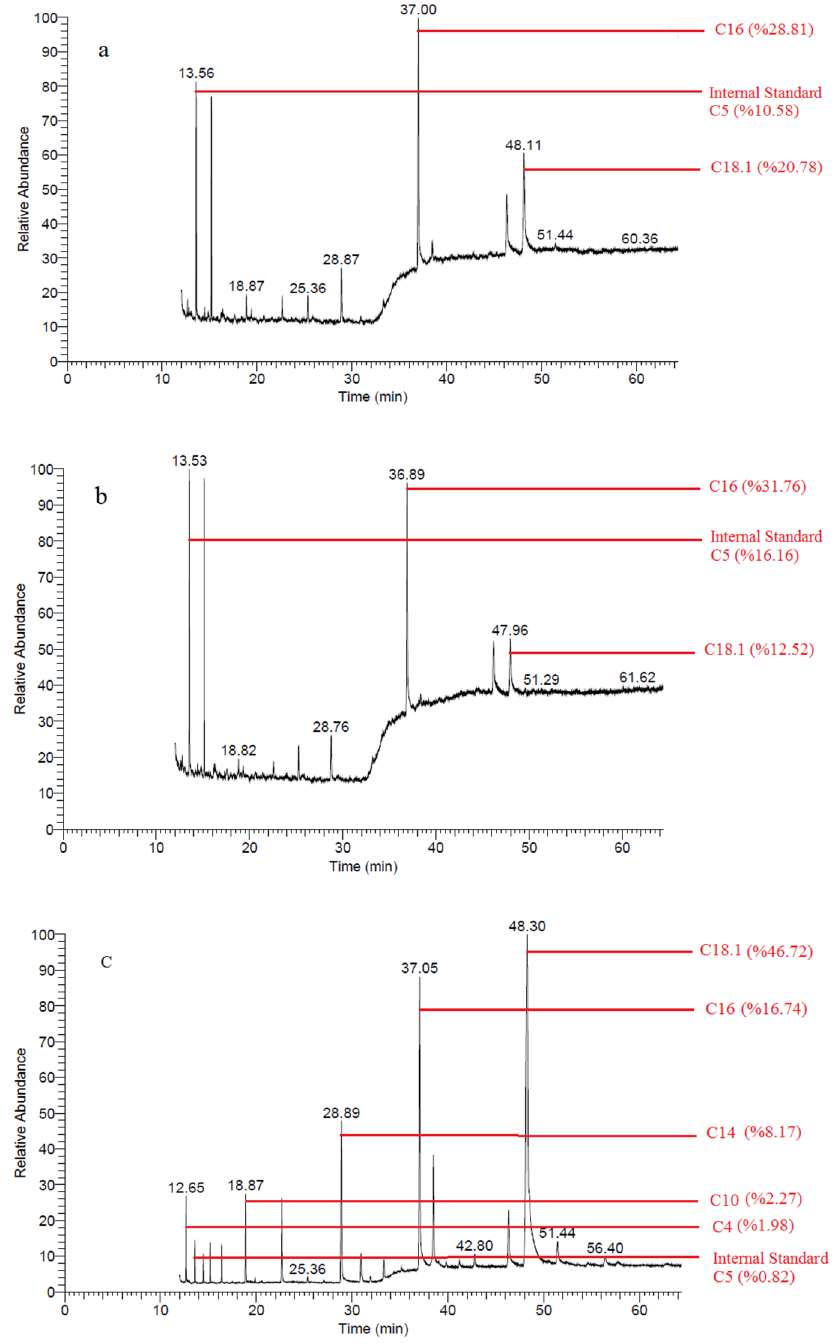
Figure 3. Free fatty acid chromatograms of samples ( a ) MAP1, ( b ) MAP2, and ( c ) Control in day 28.